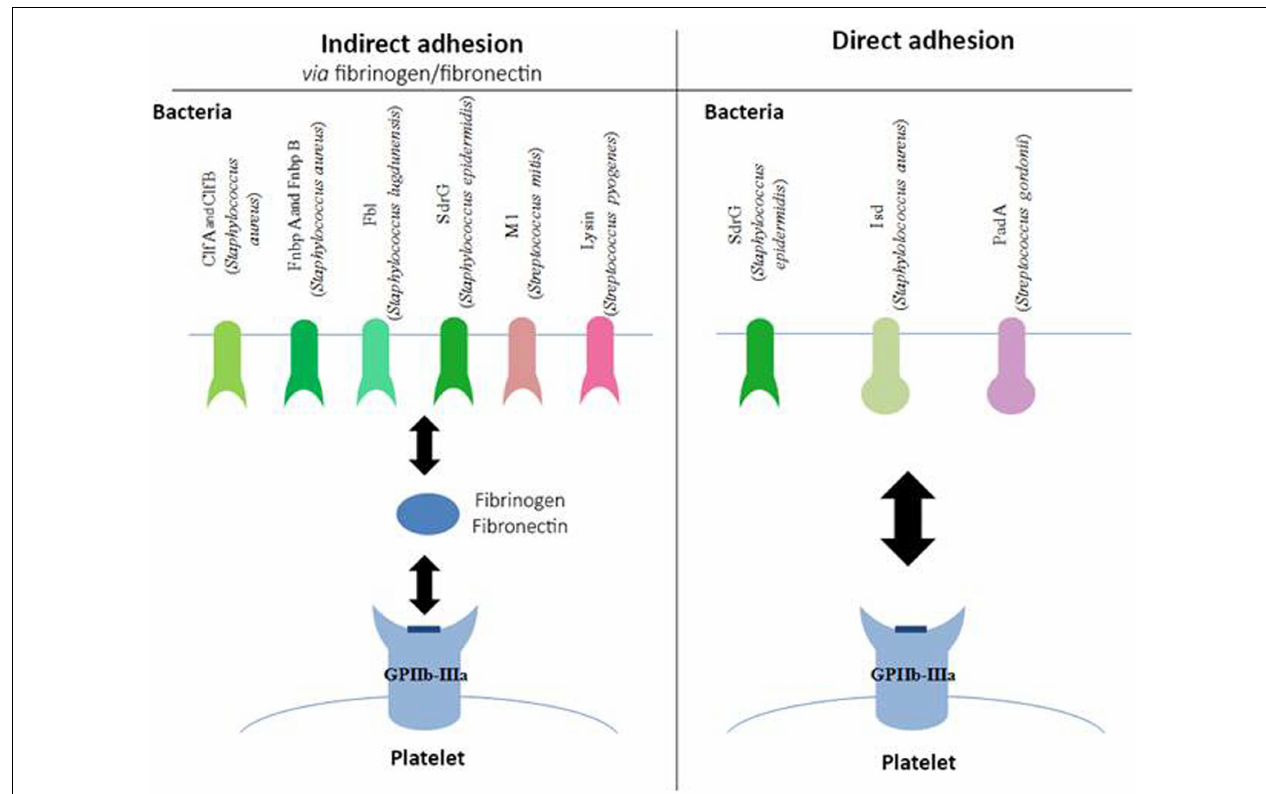
side of the diagram) or directly (right side of the diagram). Clf, clumping factor; Fnbp, fibronectin-binding protein; SdrG, serine–aspartate repeat protein; Isd, iron-regulated surface determinant; Pad, platelet adherence